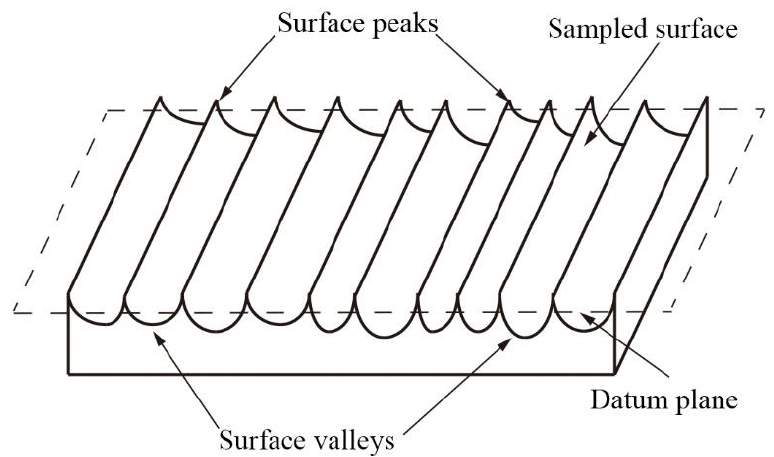
Figure 4. Surface roughness measurement equipment and method.